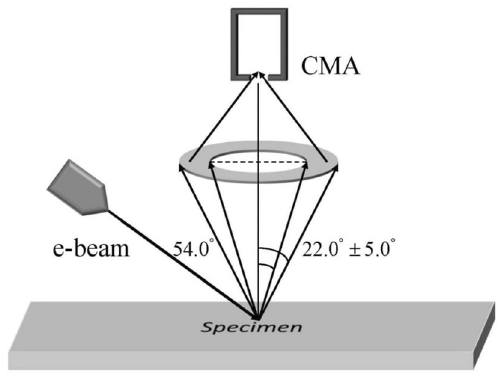
Figure 1. Schematic diagram of the REELS experimental configuration.